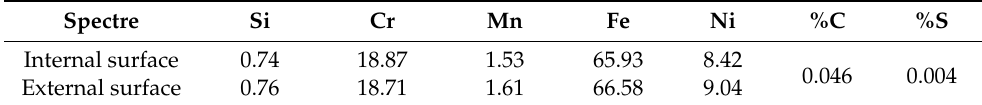
Table 4. Average values of the chemical composition of hypotubes #1–#17.